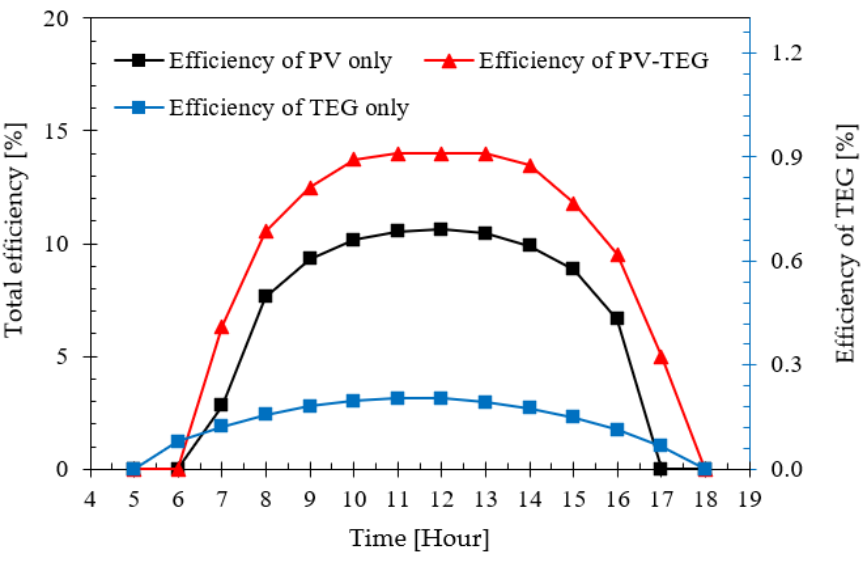
Figure 12. Efficiency of PV, PV-TEG, and TEG.